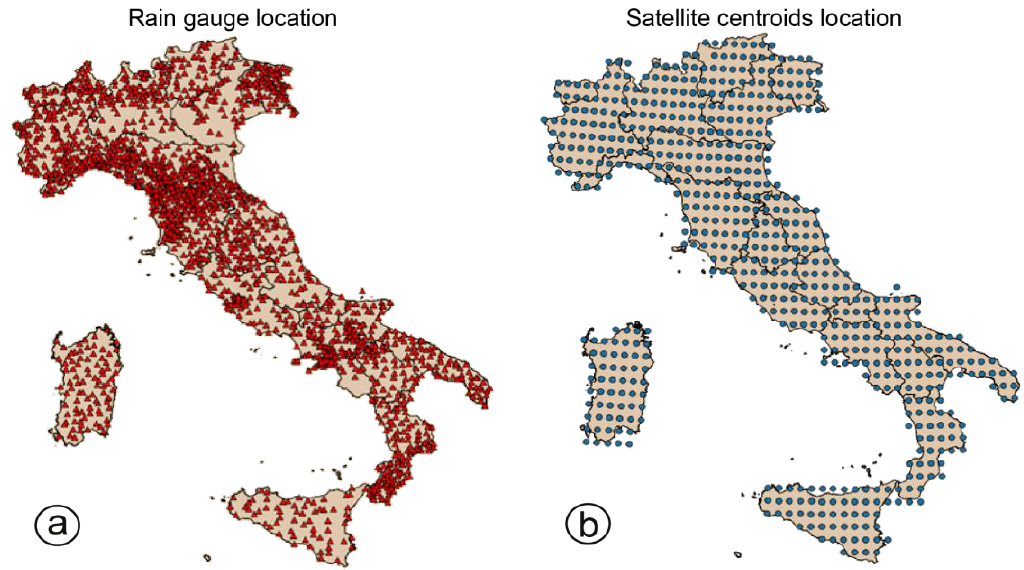
Figure 2. ( a ) Location of the rain gauges along the Italian territory (available through the Experience Platform of the Italian Civil Protection Department [54]); ( b ) Location of TRMM cell centroids (0.25° × 0.25° resolution) covering the Italian territory.